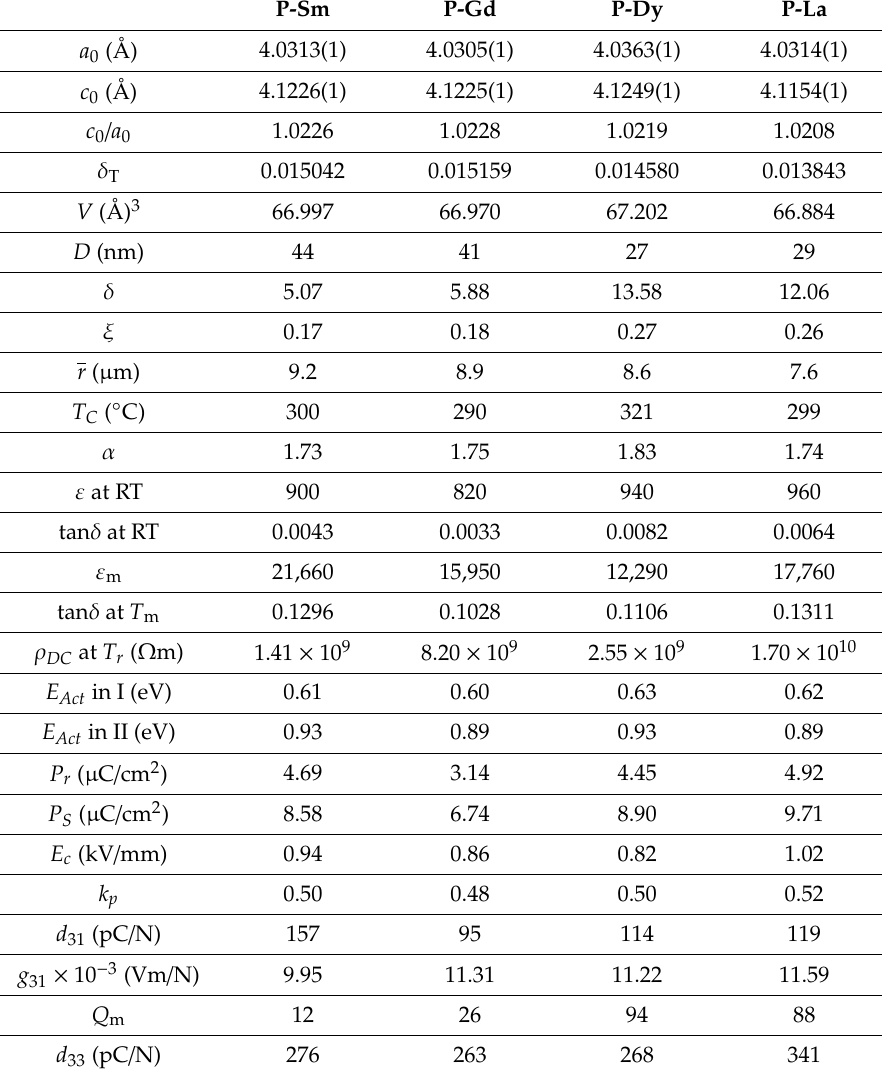
Table 1. Electrophysical properties of the multicomponent PZT-type